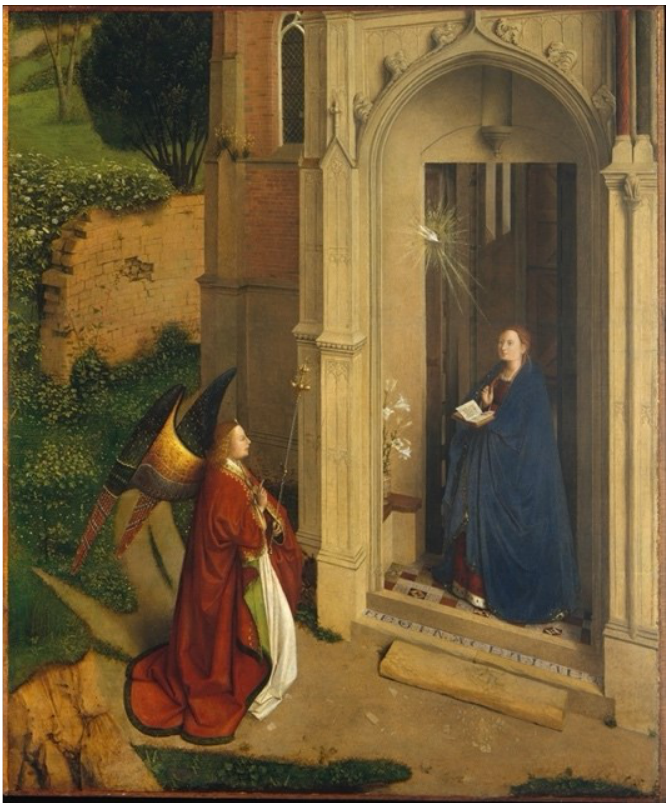
Figure 9. Petrus Christus (attributed), The Annunciation (The Friedsam Annunciation), c.1450. The Metropolitan Museum of Art, New York.